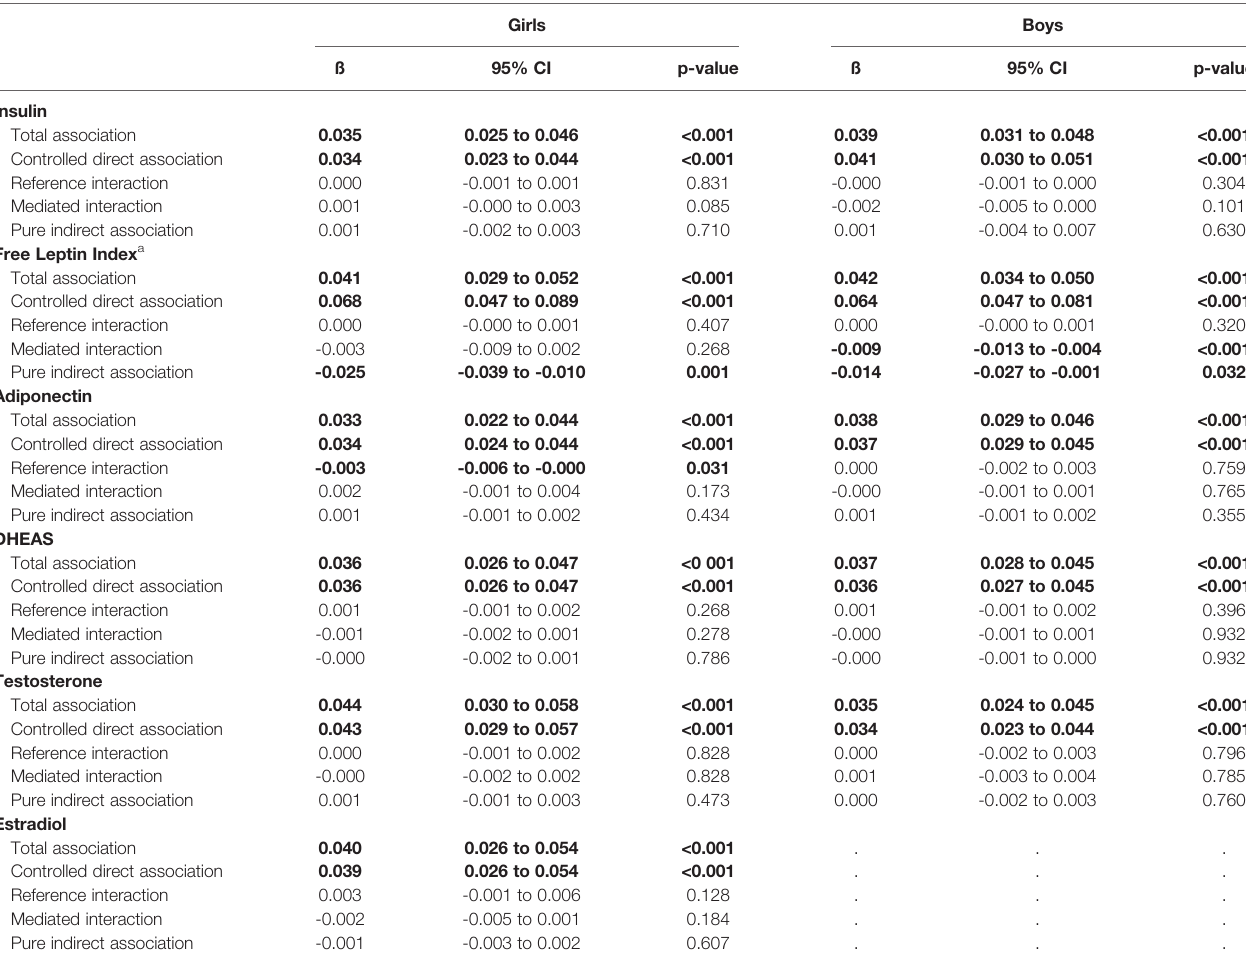
TABLE 2 | Four-way decomposition of the association between fat mass and TBLH BMC. Girls